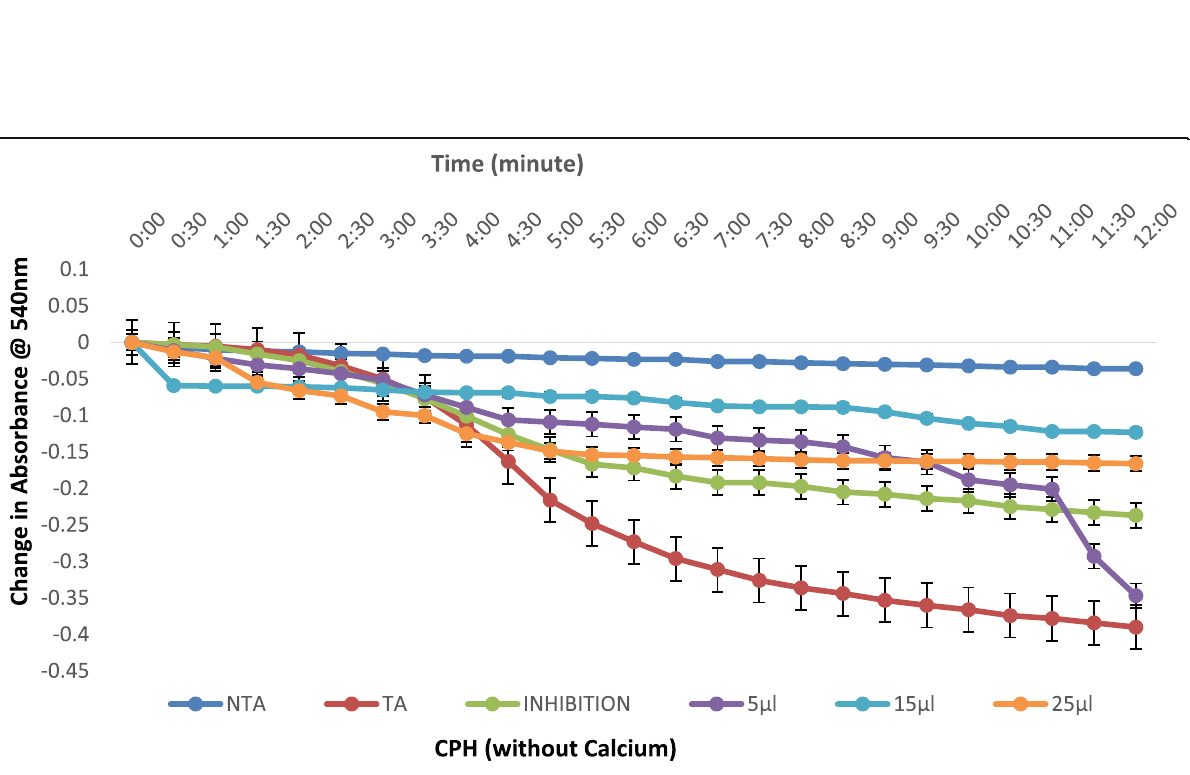
Fig. 5 Effect of varying concentrations (10 μ g/ml, 30 μ g/ml, and 50 μ g/ml corresponding to 3, 10, and 16.7 μ l) of crude ethanol extract of Cassava peel biogas slurry on rat liver mitochondrial membrane permeability transition pore in the absence of calcium (Ca 2+